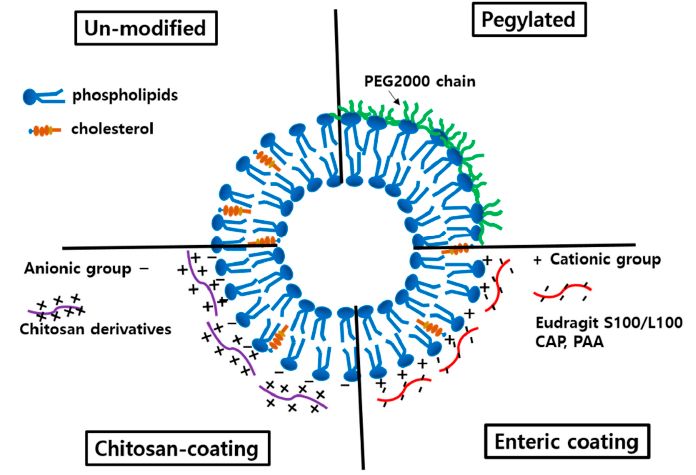
Figure 5. Surface modification of liposomes for in vivo BA enhancement .